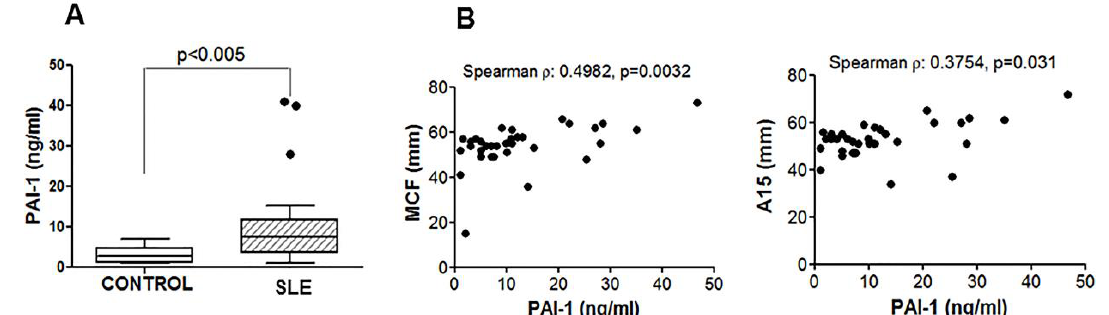
Figure 3. Plasminogen activator inhibitor-1 (PAI-1) levels in plasma and its correlation with ROTEM ® parameters. Plasma levels of PAI-1 ( A ) measured with enzyme-linked immunosorbent assay correlated with A15 and MCF parameters ( B ). A Mann–Whitney test and Spearman’s correlation were performed, and p < 0.05 was considered significant.